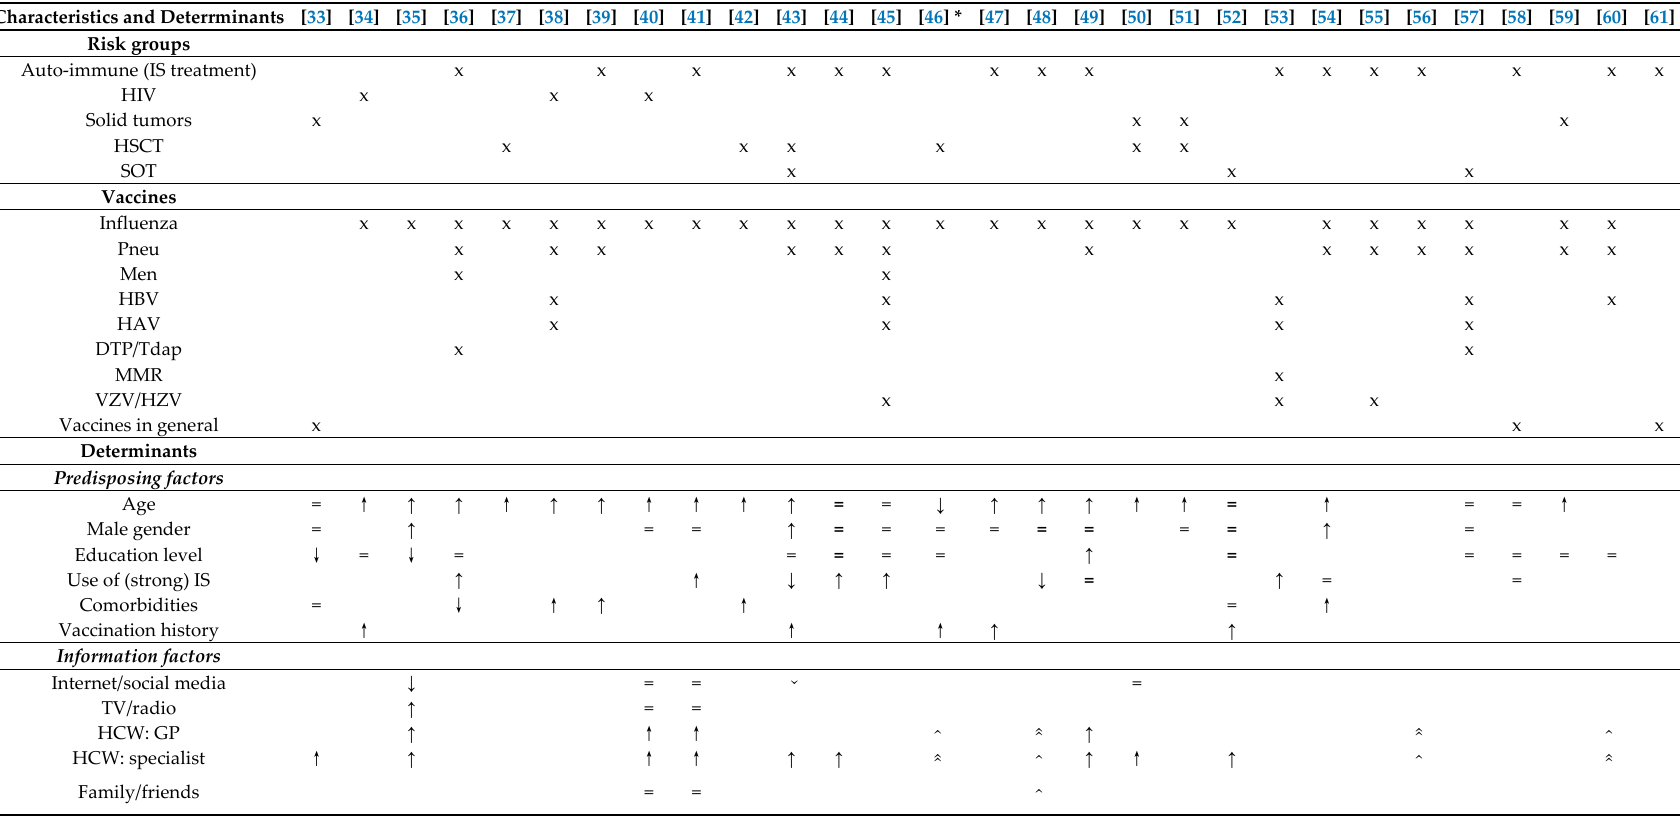
Table 3. Overview of determinants of vaccination uptake in ICP.